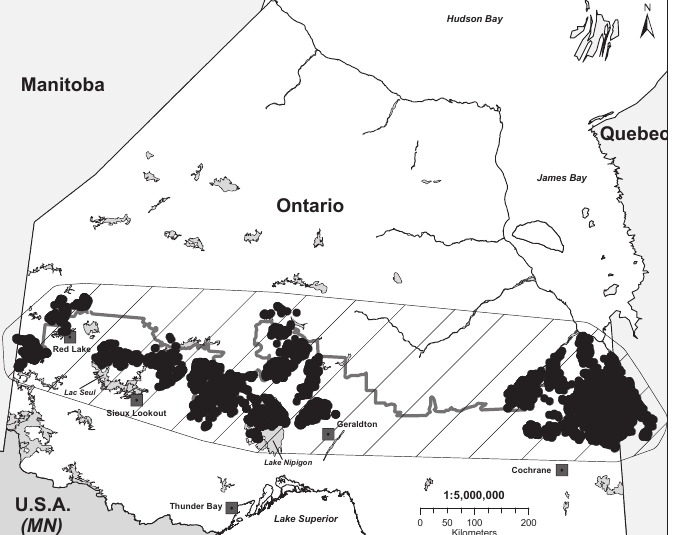
Fig. 1. Study area and locations of sampled individuals. Hatched polygon delineates the general study area, defined by a buffered (25 km) 100% Minimum Convex Polygon. Black circles represent all sub- sampled locations recorded from 1995-2008, for the 73 woodland caribou ( Rangifer tarandus caribou ) included in our analyses. Thick gray line depicts the northern boundary of commercial logging dur- ing the time period when location data were